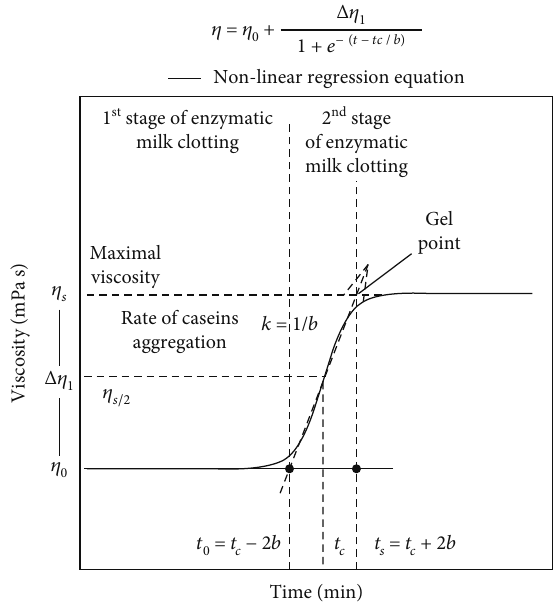
Figure 2: Sigmoidal four-parameters equation used to analyze the rheological behavior of milk clotted with bovine chymosin, recombinant camel chymosin, or trompillo proteases. η s =viscosity =initial viscosity, η s =half of the maximum at gel point, η 0 /2 viscosity, t c =time to reach half maximum viscosity, k =rate of =time to start the caseins aggregation, and caseins aggregation, t 0 t s =time to form the milk